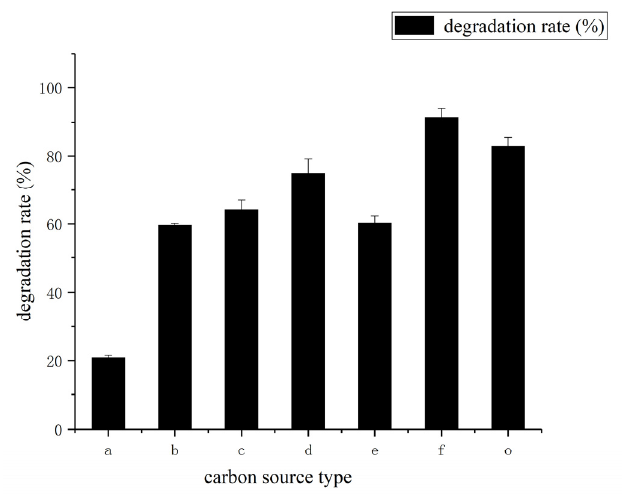
Figure 7. Effects of type of carbon source on coumarin degradation rate (a-glucose, b-fructose, c-malt dust, d-sucrose, e-lactose, f- β - cyclodextrin, o-contrast). The results are expressed as mean ± SD from three independent experiments.